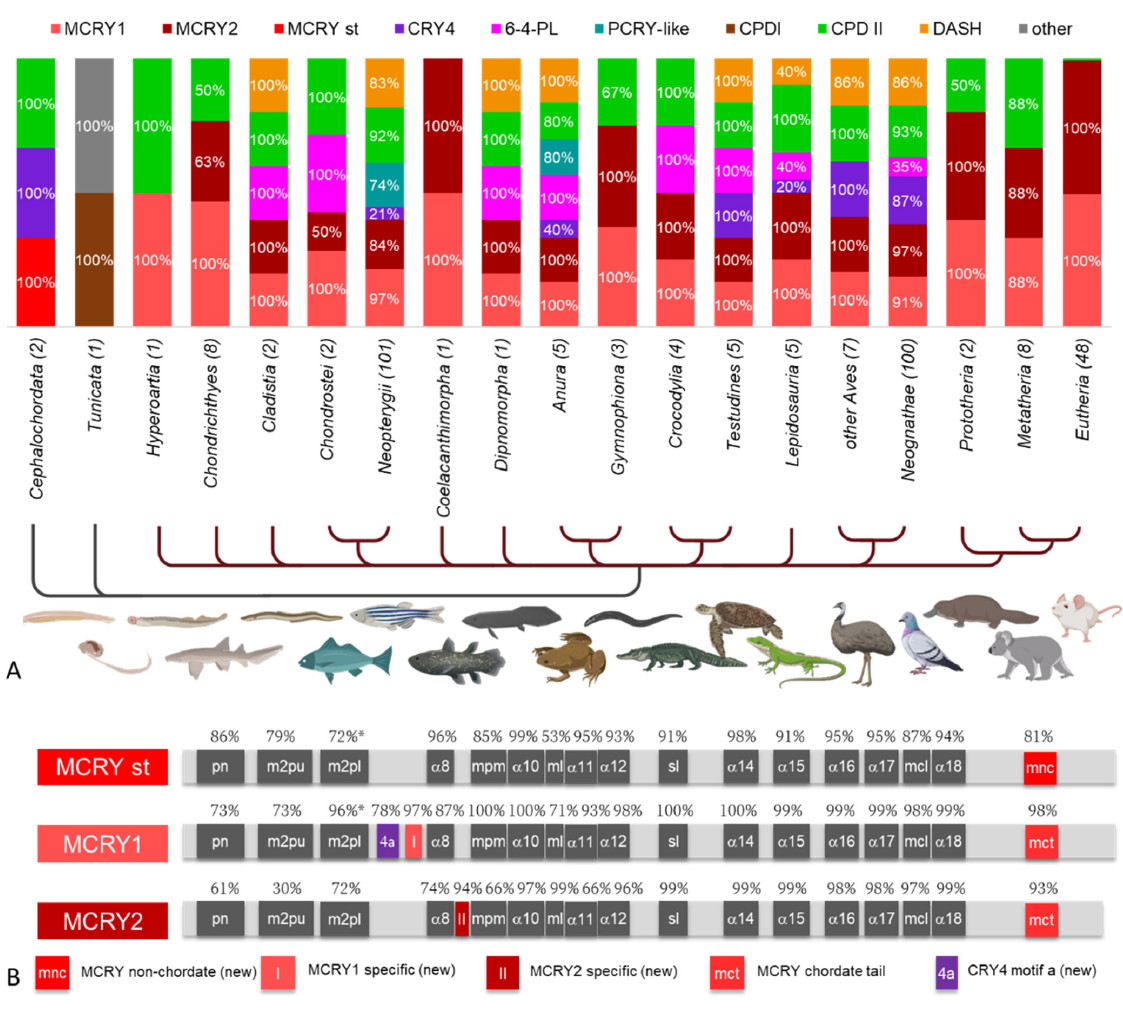
Figure 5. ( A ) Distribution of CRY/PL subfamilies within Chordata. Cephalochordata and Tunicata are shown with gray lines, while animals belonging to the subphylum Craniata are labeled with dark red lines. The prevalence of a CRY/PL subfamily within a taxon is given as a percentage. For clarity, only percentages above 10% are given. The total number of animals studied in each taxon is given in parentheses next to its name. Nearly all animals studied, with only a few exceptions, have an MCRY duplication leading to MCRY1 (light red) and MCRY2 (dark red). ( B ) Characteristic motifs of MCRY1, MCRY2 and the standard MCRYs (MCRY st) found in non-chordates. Type-specific motifs are shown in color. The motifs mnc, I, II, and 4a are novel motifs. All other motifs are explained in Figure 3.